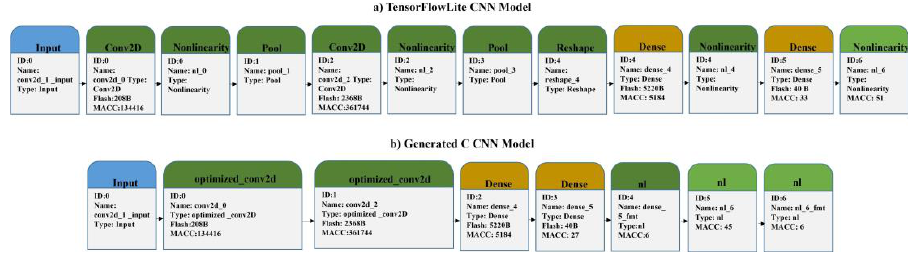
Figure 4. CNN model in TensorFlowLite and generated C-Model from STM tools.